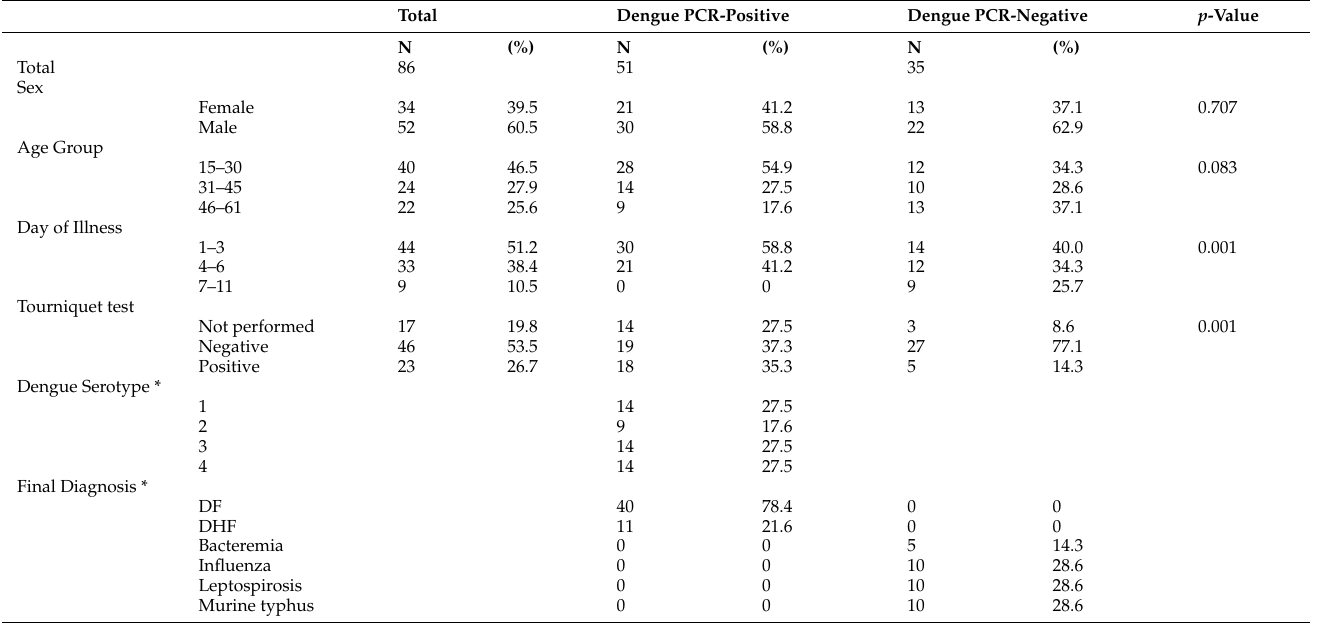
Table 1. Demographic and clinical characteristics of